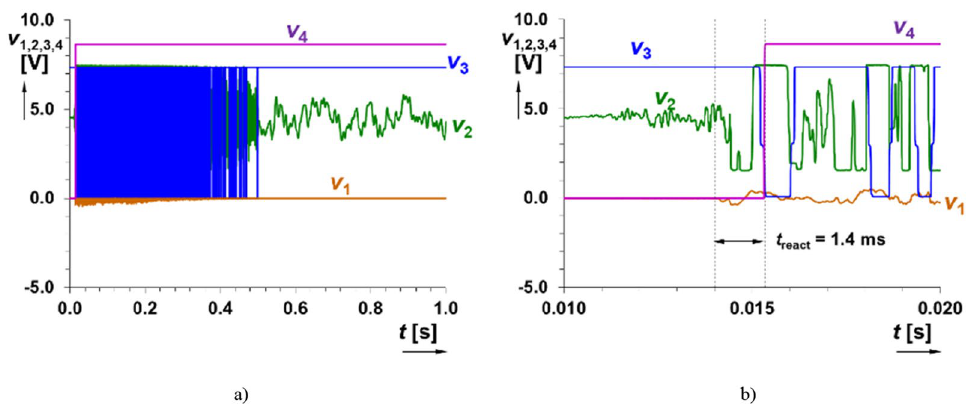
Figure 11. Simulation of time domain response of the readout system on signal pattern of a gunshot (signal intentionally limited and level overridden for threshold of reaction 50 mV): ( a ) all indicated outputs of the system and ( b ) detail on